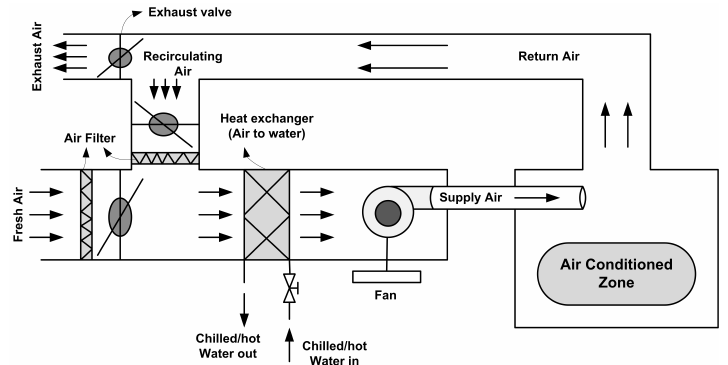
Figure 1. Air handling unit schematic drawing view with single thermal zone in the variable air volume (VAV) system.